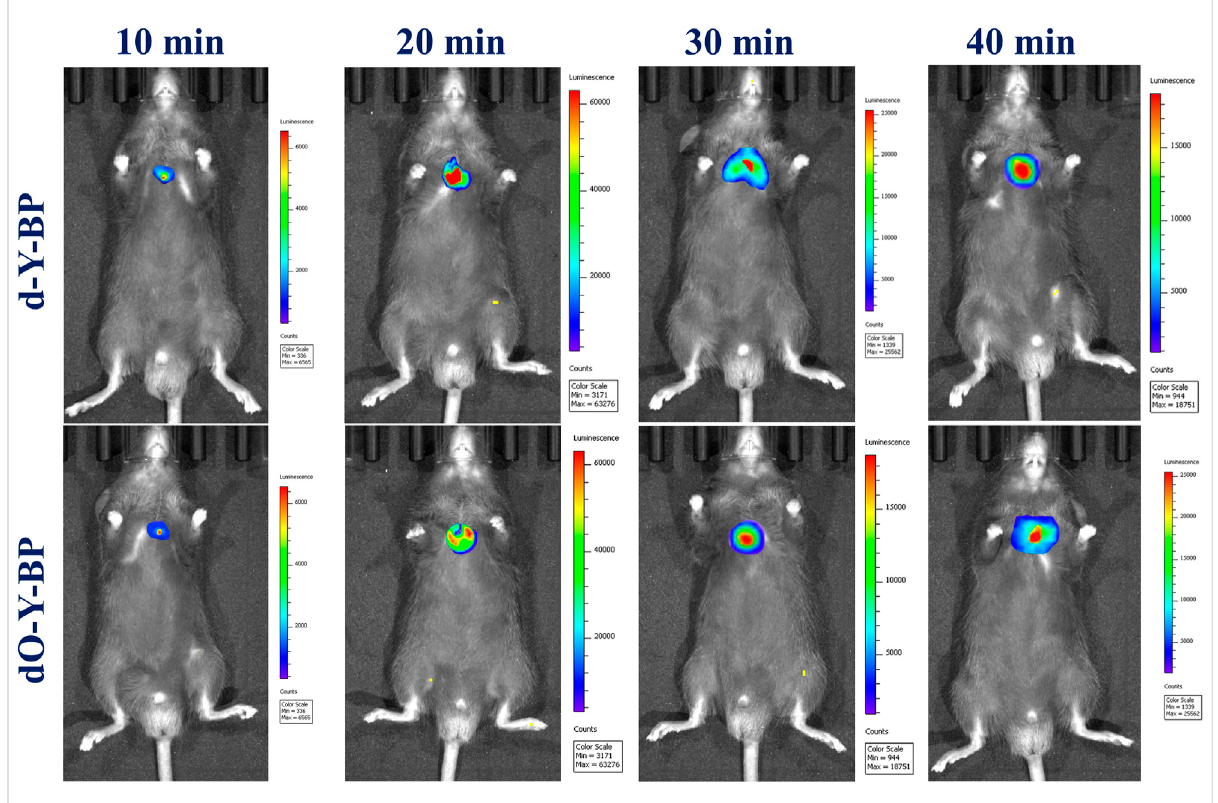
FIGURE 6 In vivo imaging of changes in the levels of d/dO-Y-BP in mice lung tumor